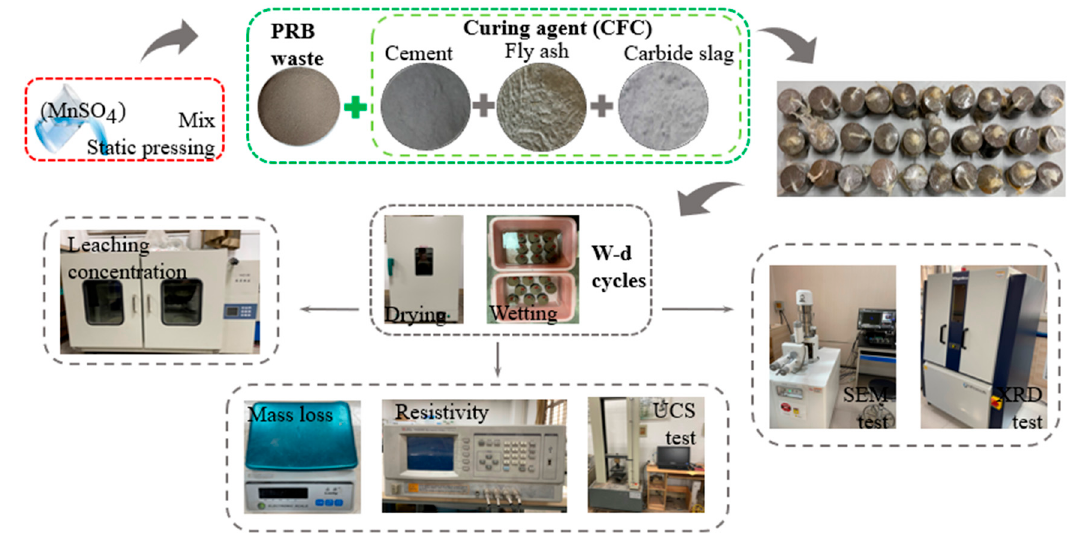
Figure 3. Testing process schematic. Table 3. Experimental